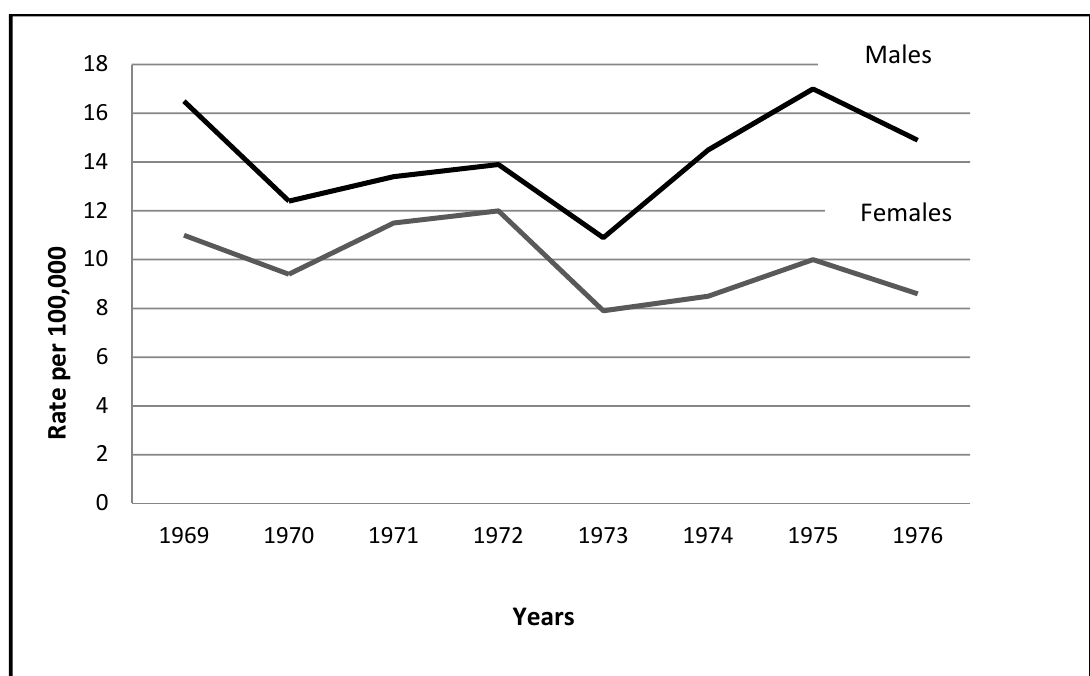
Figure 2. Time-Plot: The Yom–Kippur war (included: The War of Attrition) (10/6/1973– 11/11/1973),